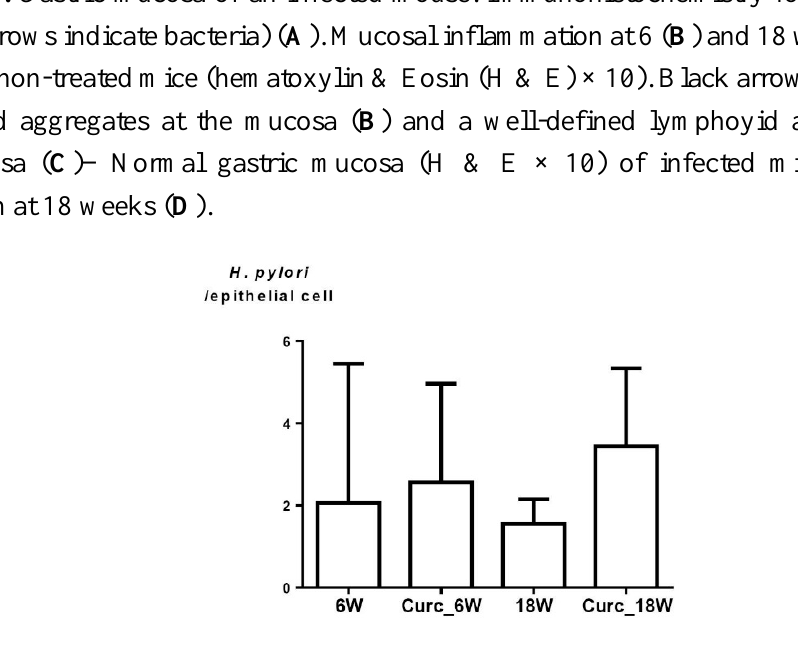
Figure 2. Quantitative real-time polymerase chain reaction (PCR) evaluating the load of H. pylori in the mouse gastric mucosa. Values denote the means of the ratio 23S rRNA/GAPDH, obtained for each of the mice analyzed in each group, each mouse tested in duplicate. 6W and 18W, refer to the groups of infected mice at 6 and 18 weeks, respectively; Curc_6W and Curc_18W, refer to the groups of infected mice, receiving treatment with curcumin, at 6 and 18 weeks,